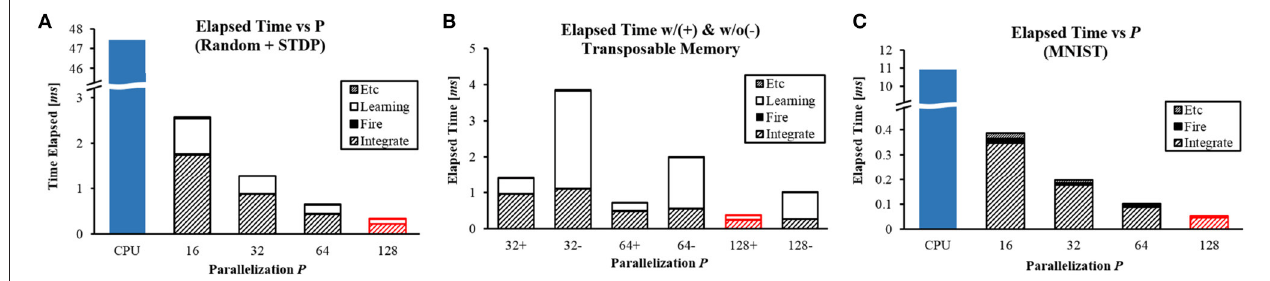
FIGURE 10 | Computation time with different P values for (A) random network with STDP learning, (B) with (+) and without ( − ) the transposable addressing scheme, and (C) MNIST inference task.